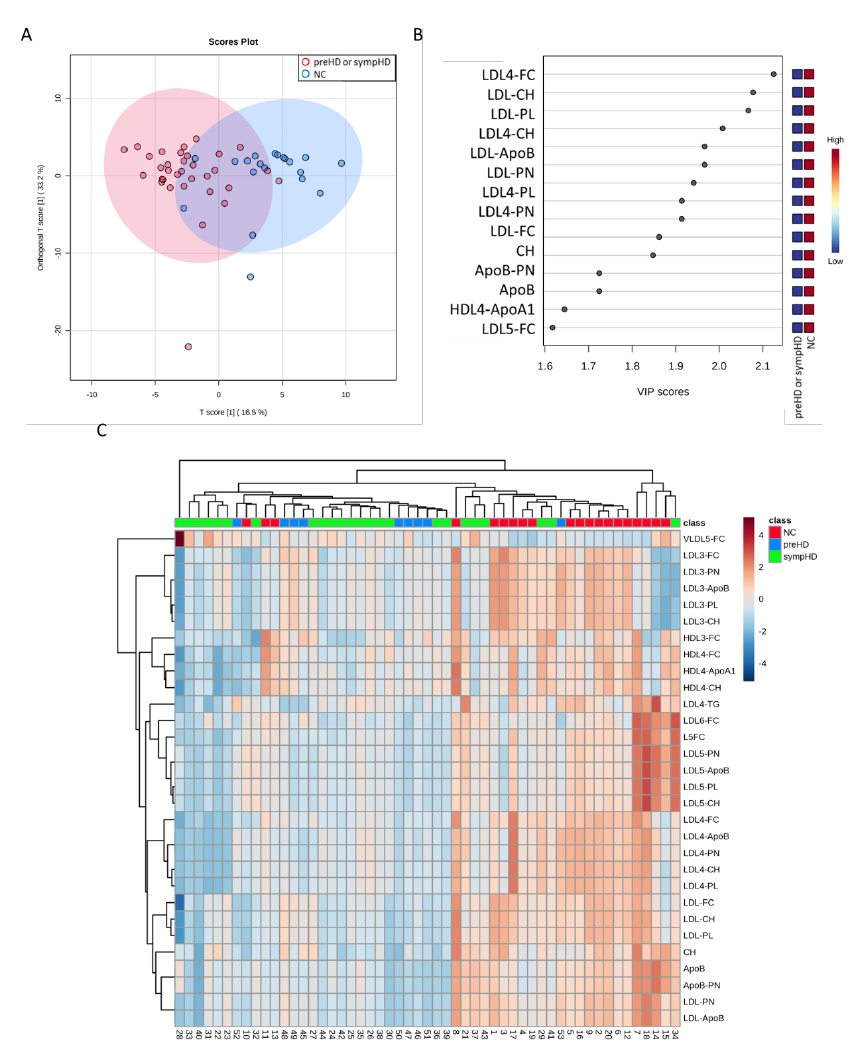
Figure 1. Orthogonal partial least squares-discriminant analysis (OPLS-DA) of normal controls (NC, n = 20) and patients with symptomatic Huntington ’ s disease (sympHD) (n = 24) or pre-symptomatic HD (preHD, n = 9). ( A ) OPLS-DA of metabolites shows a separation between the two groups (R 2 Y = 0.44, Q 2 = 0.30). R 2 Y, cumulative variation in the Y matrix; Q 2 , predictive performance of the model. ( B ) Lipoprotein components with a variable importance in projection (VIP) score greater than 1.6, indicating their contribution to the OPLS-DA model. ( C ) Heatmap of the hierarchical clustering. The dendrogram at the top shows the clustering of patients, and the dendrogram on the side shows the clustering of metabolites. The colors at the top of the heatmap represent NC, HD or preHD. The colors in the heatmap represent normalized intensities, scaled to a mean of zero and unit variance for each metabolites. ApoA1, apolipoprotein A1; ApoB, apolipoprotein B; CH, cholesterol; FC, free cholesterol; HDL, high-density lipoprotein; LDL, low-density lipoprotein; PL, phospholipid; PN, particle number; VLDL, very low-density lipoprotein.